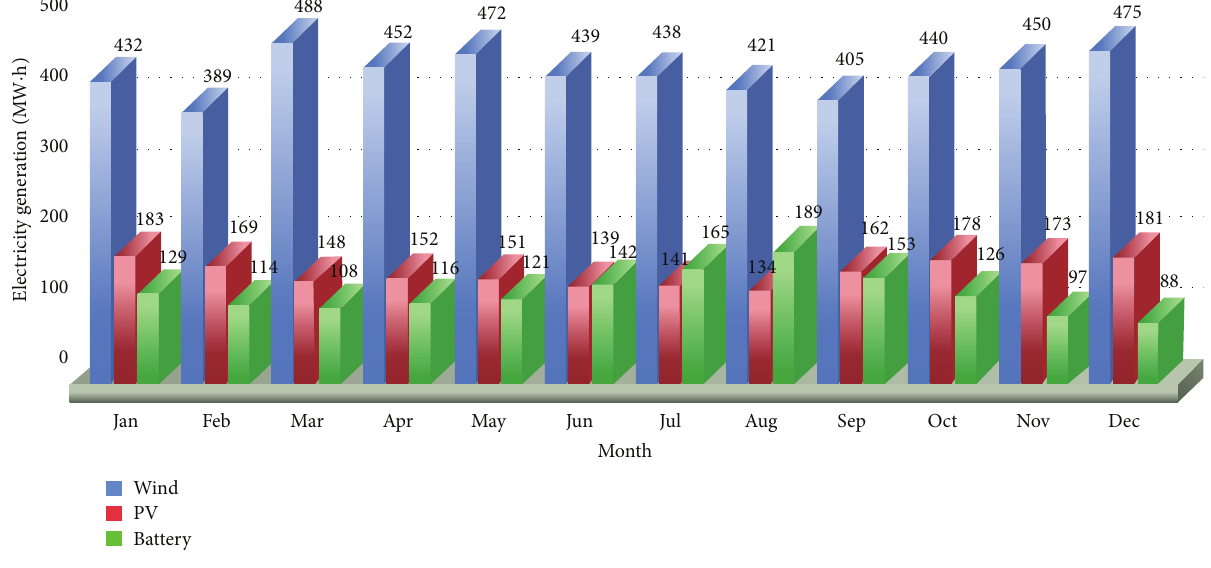
Figure 8: Comparison of the monthly electricity generation of wind, PV, and battery.